Question: How would you classify this visualization?
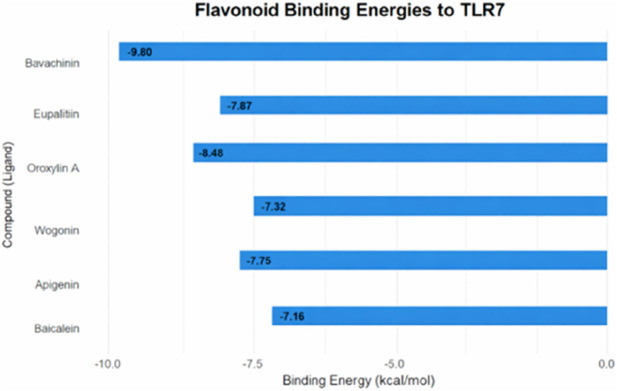
Answer: bar